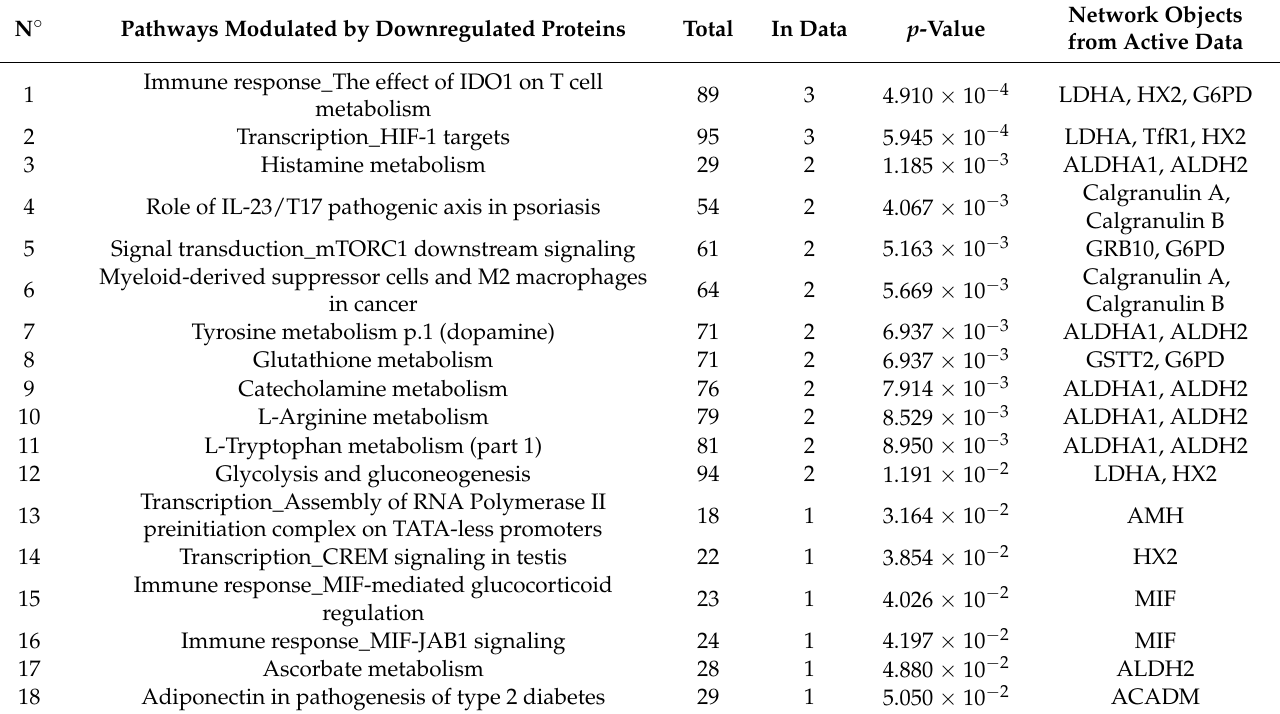
Table 1. MetaCore enrichment analysis of proteomics data in LNCaP PCa cells overexpressing miR- 423-5p. Significant pathways modulated by downregulated proteins in LNCaP PCa cells expressing miR-423-5p mimic compared to control (empty vector) ( p -value ≤ 0.05). Quantitative SWATH-mass spectrometry data analysis performed with the SCIEX OneOmics cloud processing platform (n =